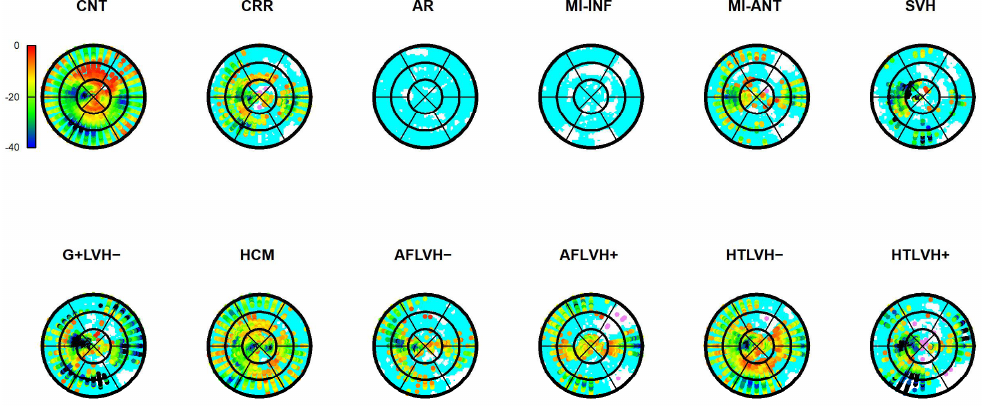
Figure 8. Per-category and per-landmark median values Δk measuring Endo-Epi α p absolute differences. For each category all landmark locations were subjected to the Wilcoxon paired nonparametric test (i.e., endo- vs. epi-). Regions are colored according to the color bar at top left; Δk < −40 are colored in black: Δk > 0 and with a significant test (very limited) are colored in violet; Δk with a non-significant test are colored in cyan if <0, in white if >0. Abbreviations: Control healthy subjects (CNT), Cirrhosis (CRR), Aortic regurgitation (AR), Myocardial infarction of inferior wall (MI-INF), Myocardial infarction of anterior wall (MI-ANT), Mutation carriers for hypertrophic cardiomyopathy with LV hypertrophy (HCM), Secondary ventricular hypertrophy (SVH), Mutation carriers for hypertrophic cardiomyopathy without LV hypertrophy (G+LVH−), Atrial fibrillation without ventricular hypertrophy (AFLVH−), Atrial fibrillation with ventricular hypertrophy (AFLVH+), Hypertension without LV hypertrophy (HTLVH−), and Hypertension with LV hypertrophy (HTLVH+).